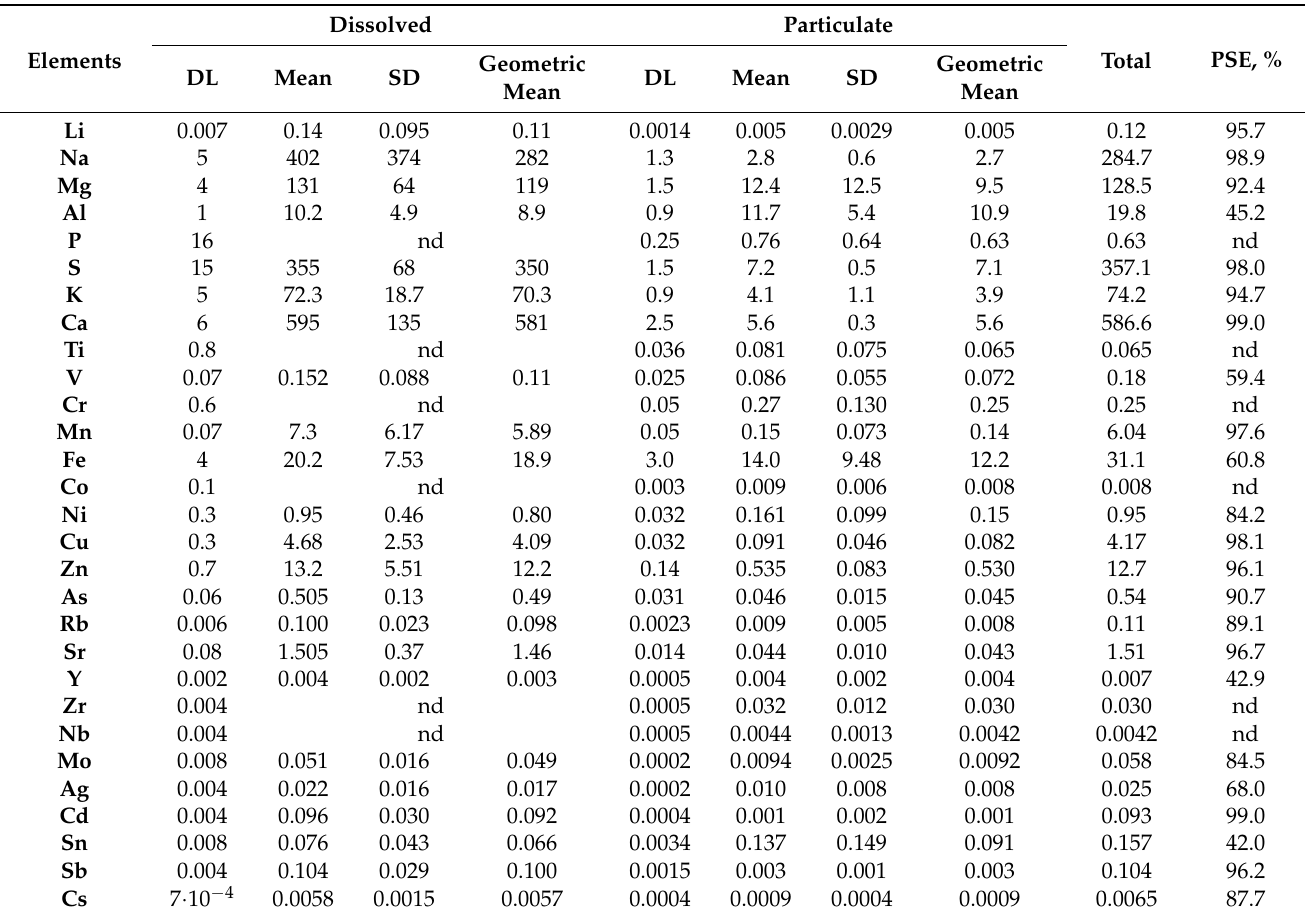
Table 1. The elemental composition ( µ g L − 1 ) of meltwater from the background